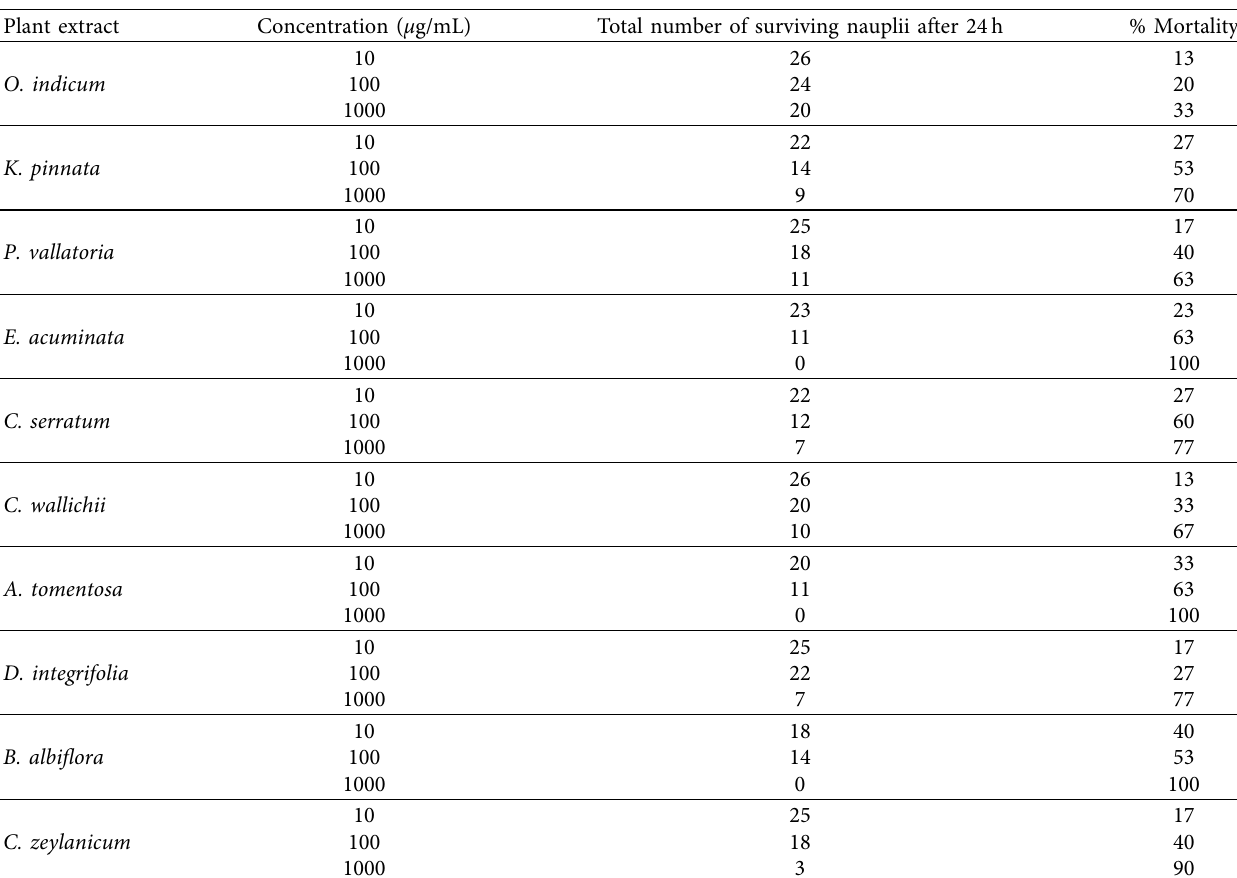
Table 2: Te number of survived brine shrimp nauplii after treatment with plant extracts and their percentage mortality. Plant extract